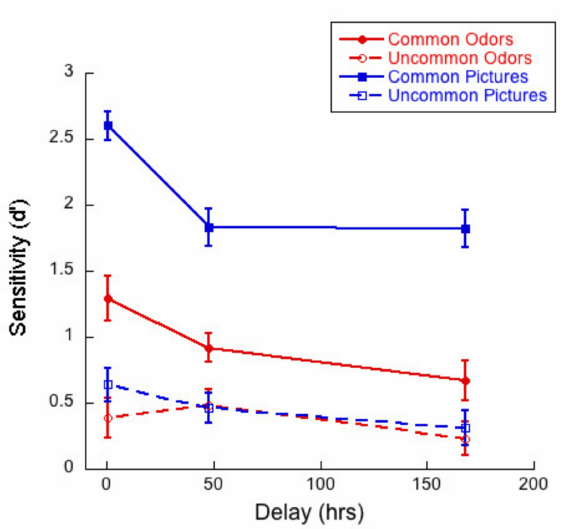
Figure 10. Sensitivity (d’) as a function of delay for each of the four test conditions. There were 20 participants in each delay